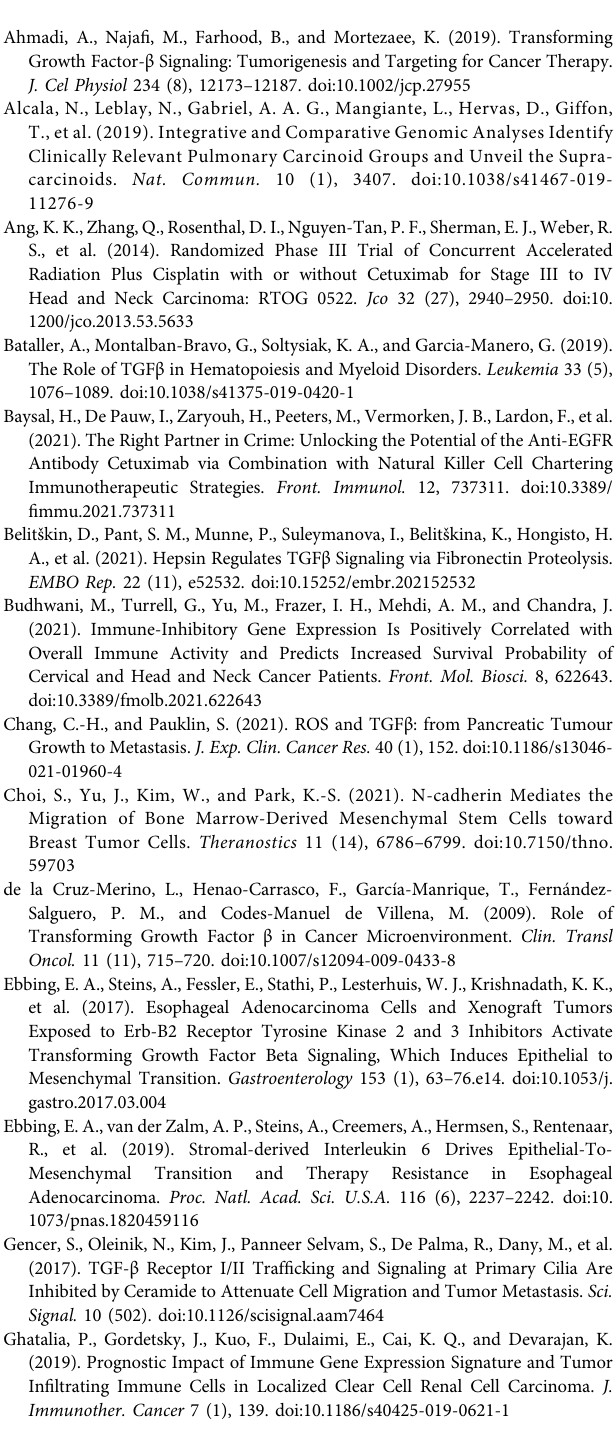
Comparison of risk scores among clinical stage-based subgroups. (E) Comparison of risk scores among sex-based subgroups. (F) Comparison of risk scores among age-based subgroups. (G) Comparison of risk scores among grade-based